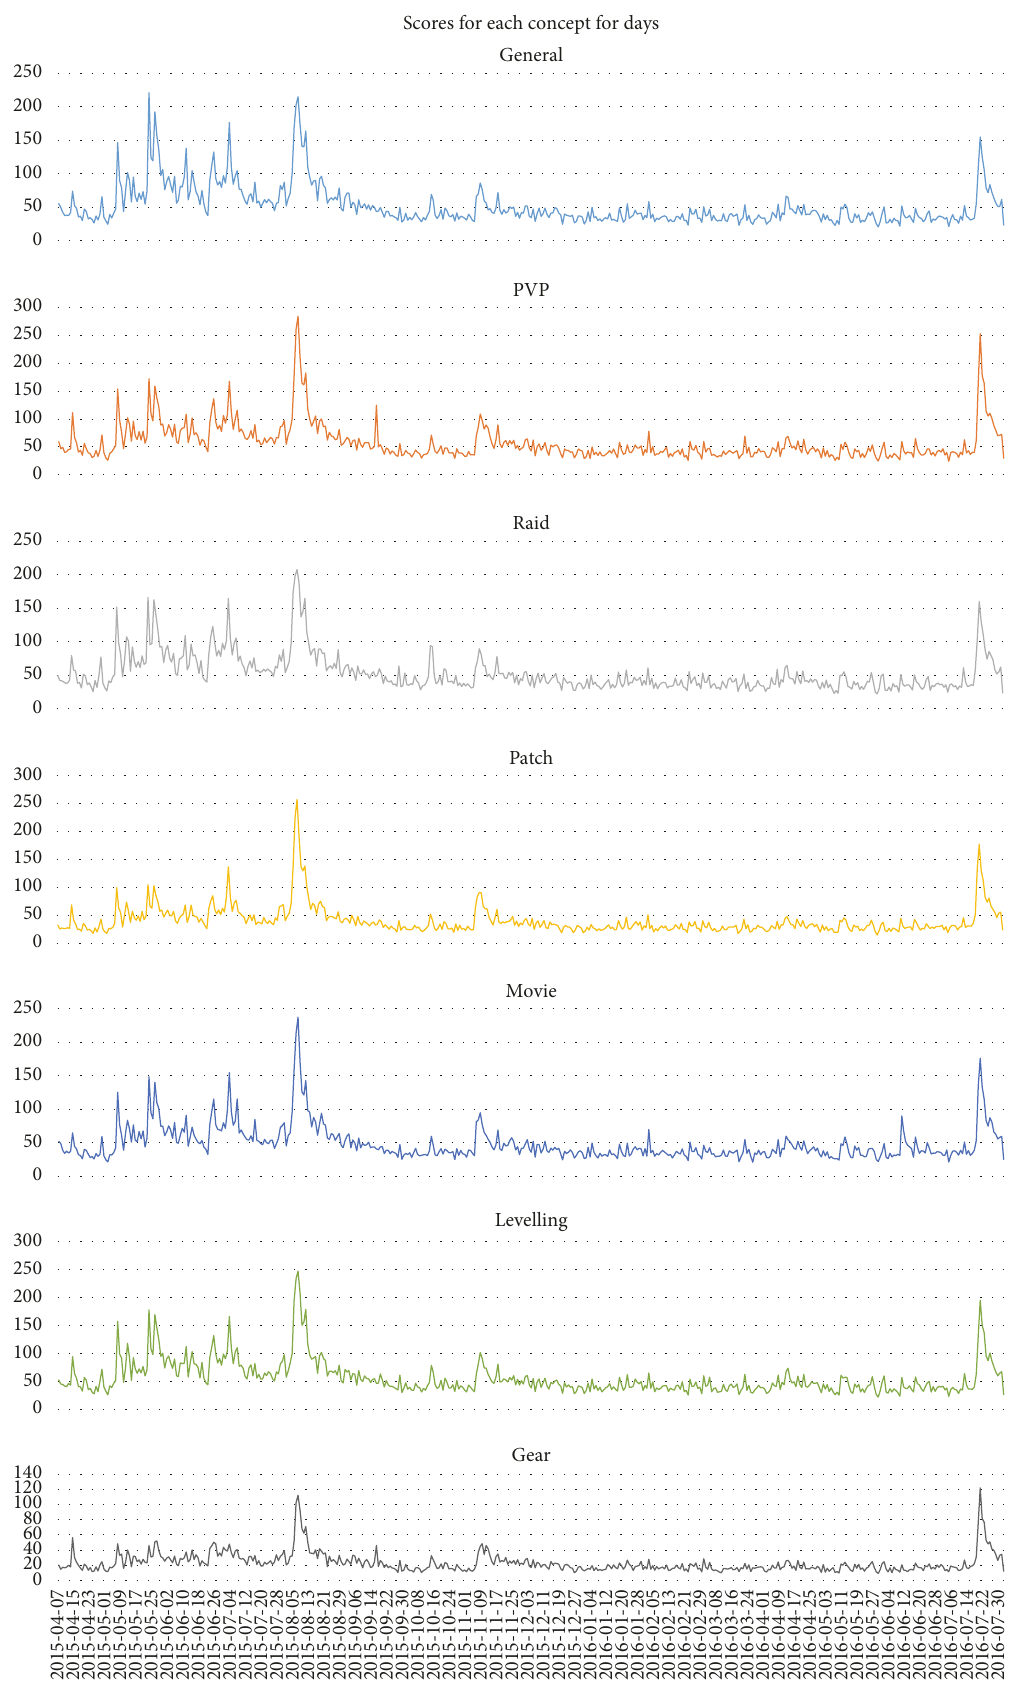
Figure 3: Scores of each concept for